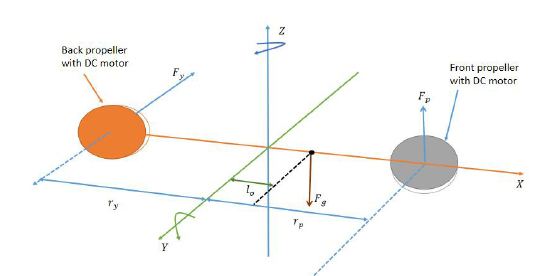
Figure 1. Schematic of the 2DOF helicopter